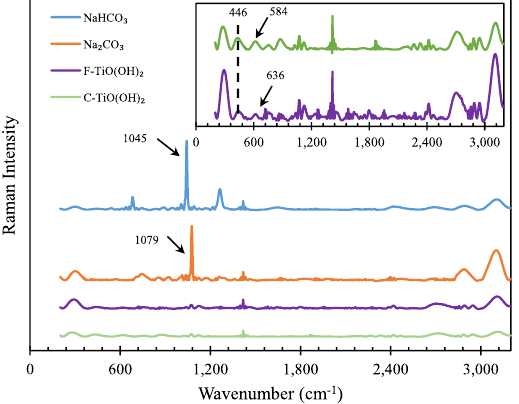
Figure 8. Raman spectra of F-TiO(OH) 2 , C-TiO(OH) 2 , pure Na 2 CO 3 and NaHCO 3 .